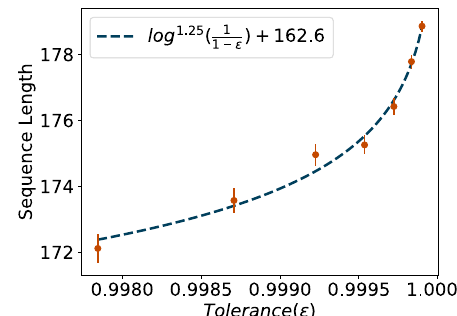
Fig. 4 Relation between sequence length and tolerance. Each data point is obtained by averaging the length of the approximating sequence of gates found by a trained agent using a validation set of 10 7 unitary targets. The error bars report the standard deviation. The agent was trained to achieve a fi nal tolerance of 0.9999 average gate fi delity (AGF). The targets are built as compositions of small rotations around the three axes of the Bloch sphere, as described in Supplementary Note 3.1. The data are fi tted by a polylogarithmic function (dashed blue line) with R 2 = 0.986 and RMSE = 0.26.